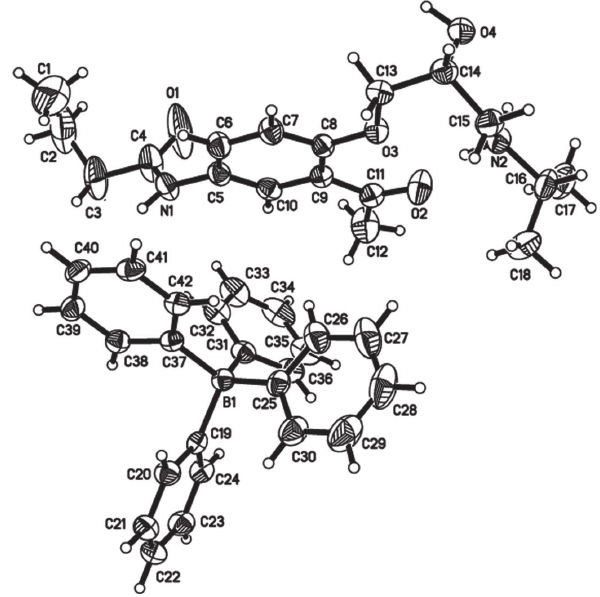
Table 1: Data collection and